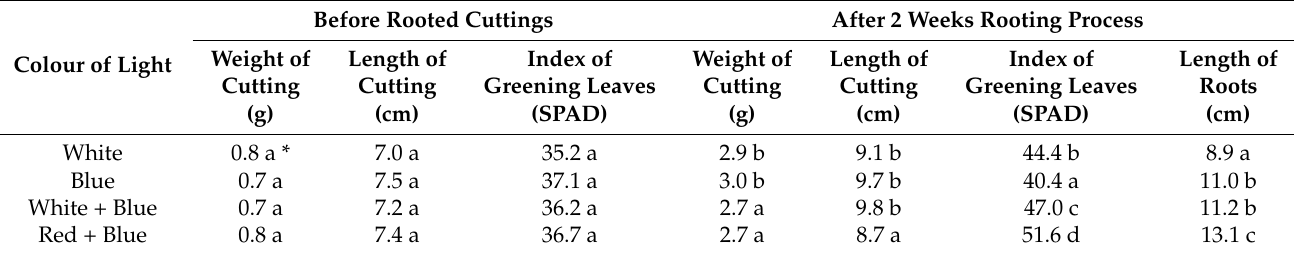
Table 1. The effect of light colour to rooting cuttings of